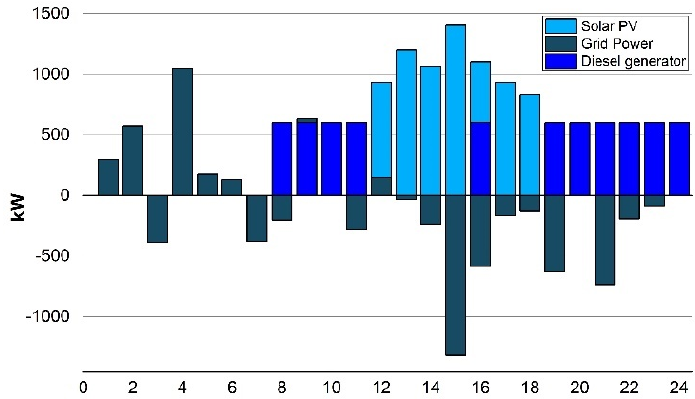
Figure 6. Scenario 1(b): Energy exchange with the power grid.